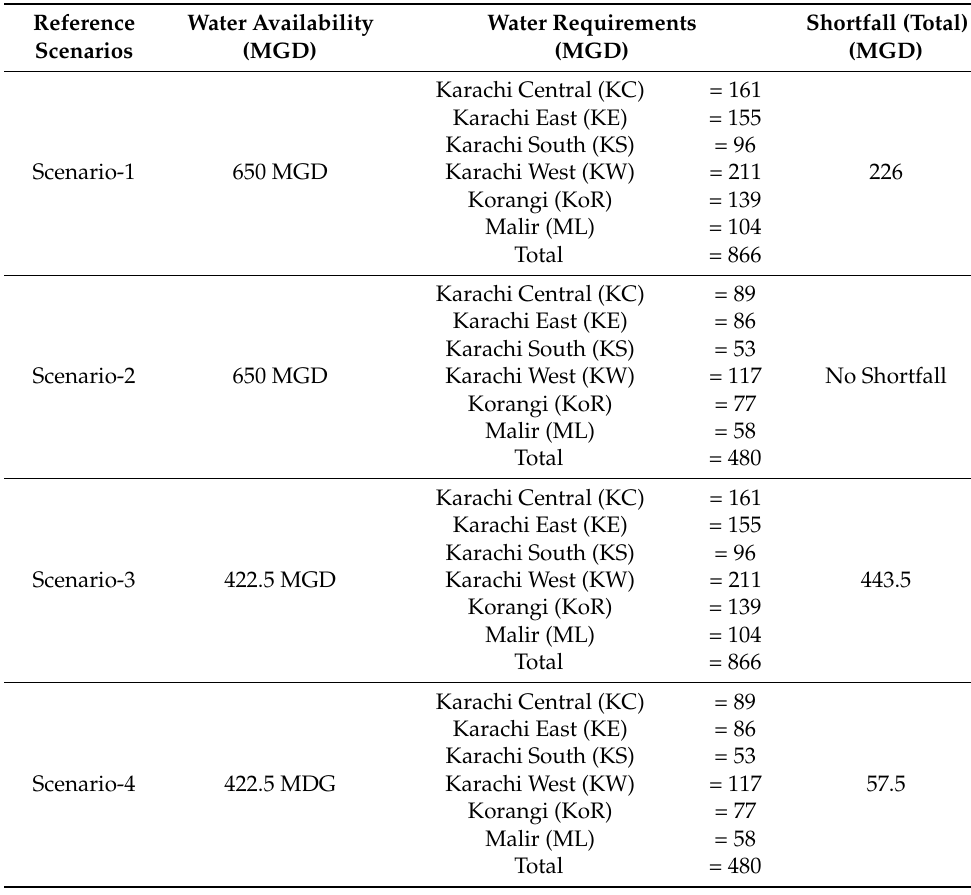
Table 4. Water availability, requirements and deficits under different scenarios.